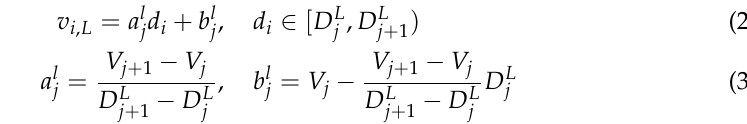
Figure 3. The modeling of speed limit and altitude, where V j is the maximum speed at D L the altitude at D h . Altitude and speed limit curve are divided into O and M segments, respectively. k The values of O and M can be adjusted according to the actual engineering situation to ensure that the linear relationship between two adjacent points is close to the actual